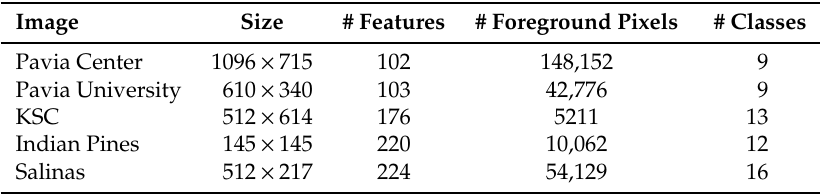
Table 1. Description of the hyperspectral images. KSC, Kennedy Space Center. Image Size # Features # Foreground